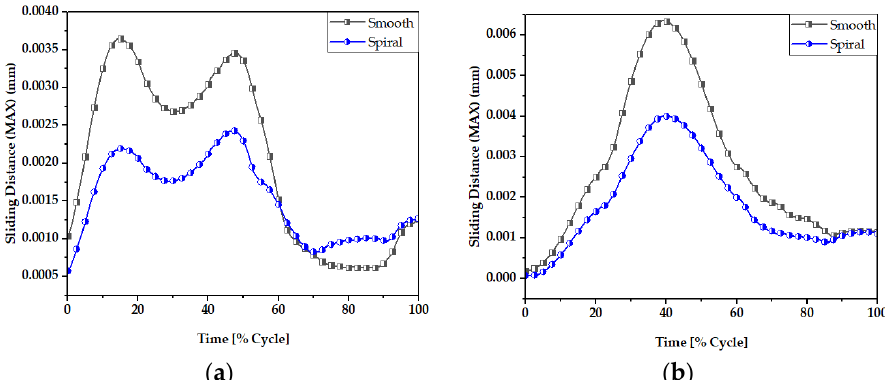
Figure 11. Maximum sliding distance of smooth and spiral head-neck tapered joints during ( a ) walk- ing and ( b ) jogging loading conditions.